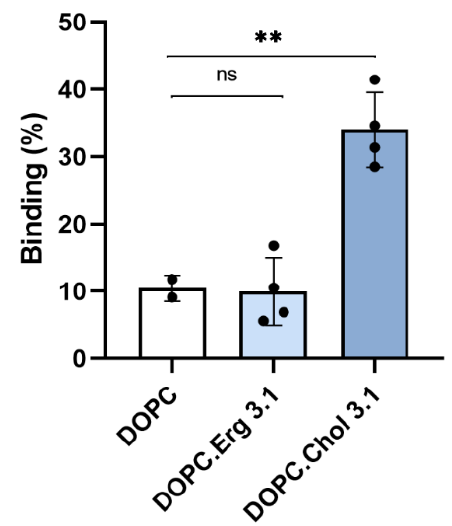
Figure 1. Binding of full length ACT to vesicles of different lipid composition. Membrane association of ACT to lipid bilayers of different lipid composition as measured by flotation assays using large unilamellar vesicles composed of DOPC, DOPC:Chol (1:1 molar ratio) or DOPC:Ergosterol (1:1 molar ratio). Details on the flotation assay methodology are provided in the Experimental Procedures section. The mean and standard deviations of three independent experiments are shown. Statistical differences are based on One-way ANOVA test with Dunnett’s T3 multiple comparisons; [ns] non- significant p ≥ 0.05 and ** p ≤